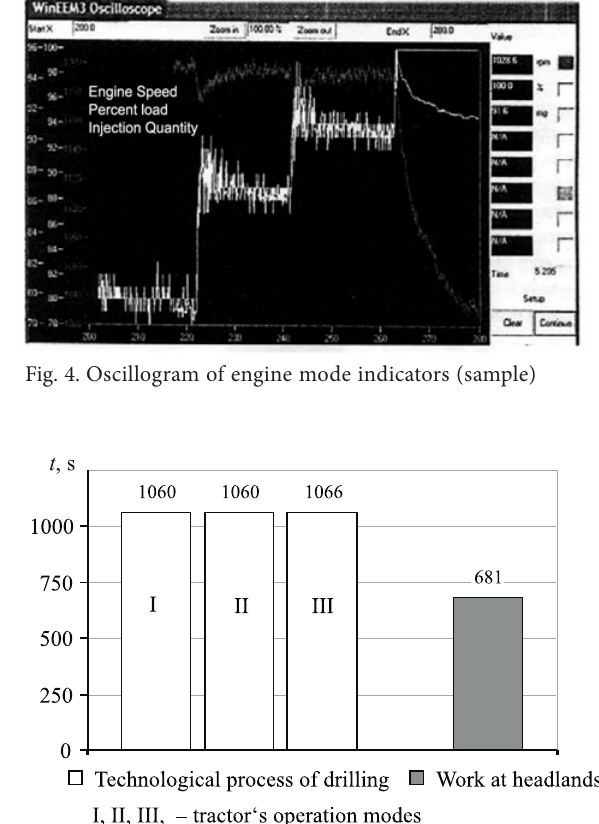
Fig. 5. Distribution of drilling process times between operating